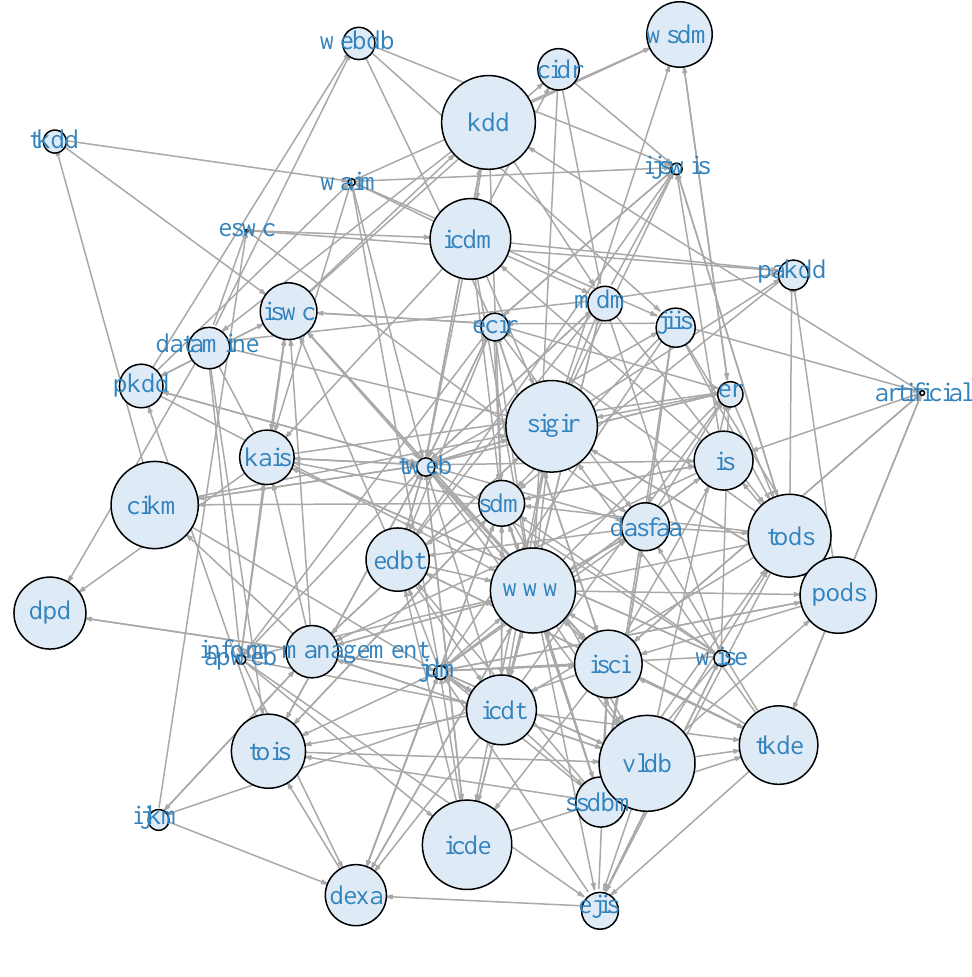
Figure 7. Influence dependency graph of DM conferences, using Citation Ratio and Unity priority function, where each edge represents pairwise Running Influence relation between conferences (Algorithm 2 using CR) for DM conference